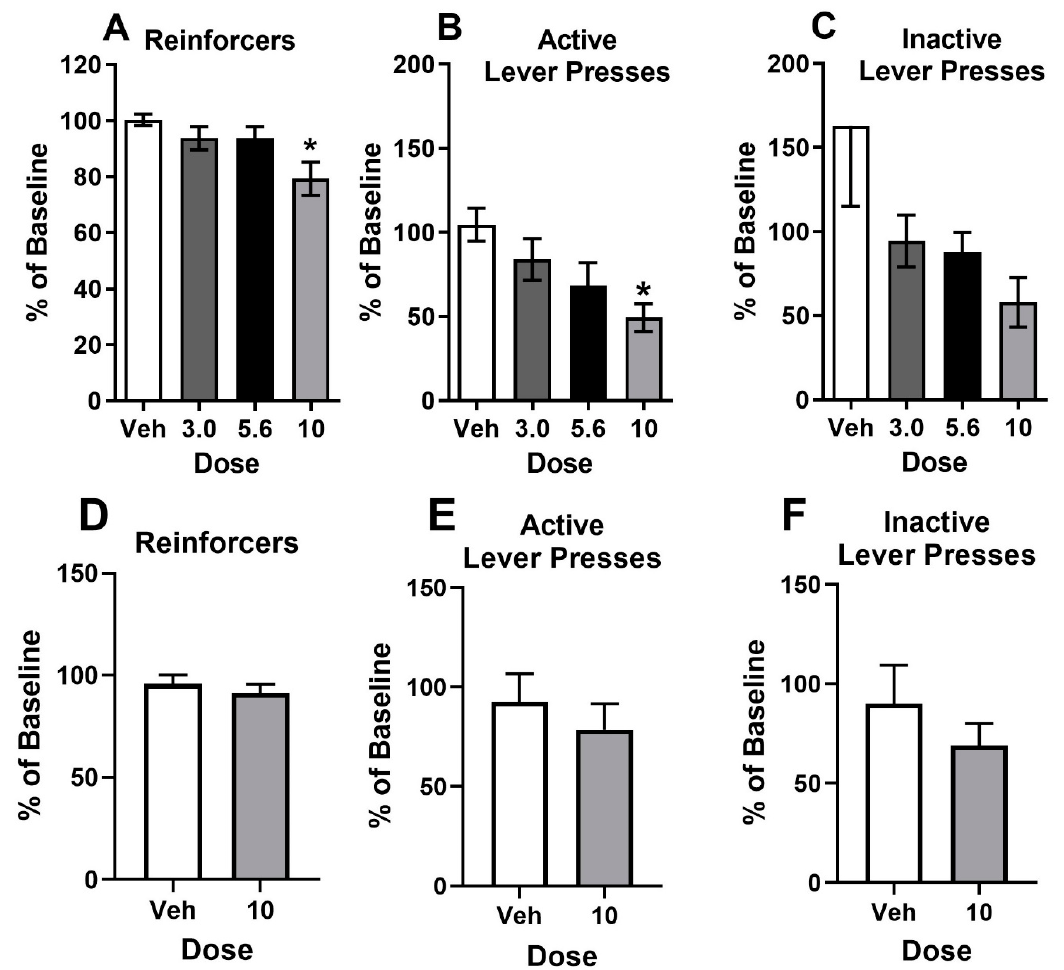
Figure 3. Effects of MC-25-41 (Vehicle, 3.0, 5.6, and 10 mg/kg) on behavioral measures under a progressive ratio (PR) schedule of reinforcement. Rats ( n = 7) tested on the PR schedule of cocaine reinforcement ( A – C ) were tested on each of the four doses on separate test days. Rats ( n = 17) tested